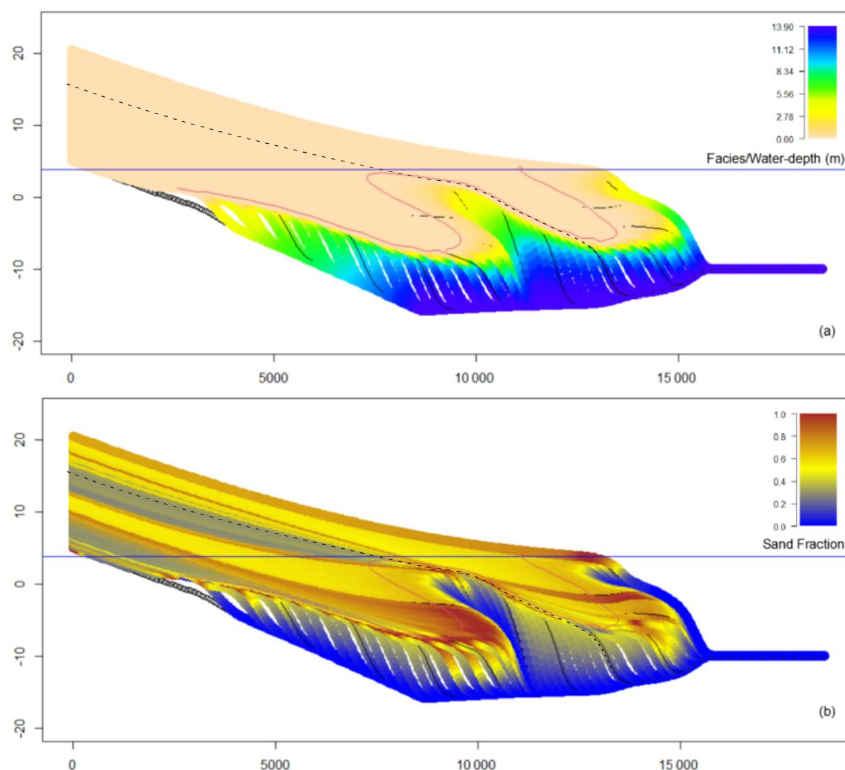
Figure 5. Simulated stratigraphy under two full sea level cycles: (a) facies section and (b) lithological section.